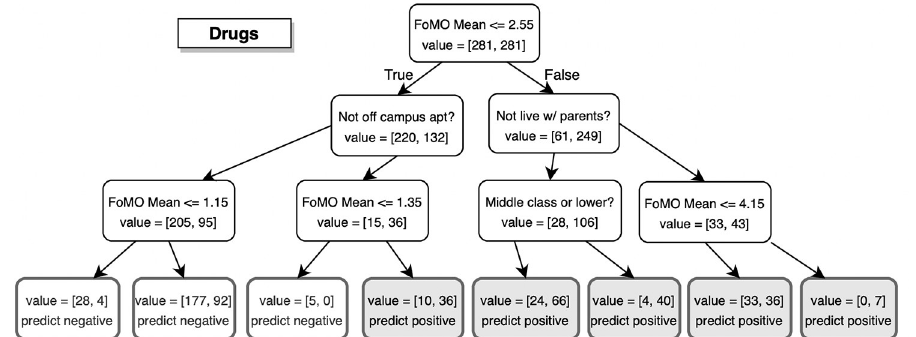
Fig 2. Decision tree output for drug use. Decision tree for drug offense/use classification based on the FoMO aggregate scenario. Starting at the root node, an example is evaluated in a sequential manner down the tree based on the conditions in the decision nodes. A classification is made according to the end node reached (blue denotes a positive prediction and light orange a negative